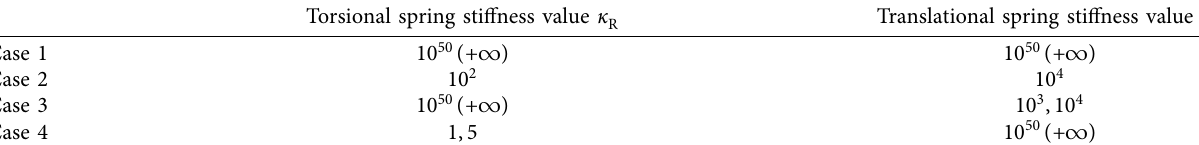
and DC voltage under different 3